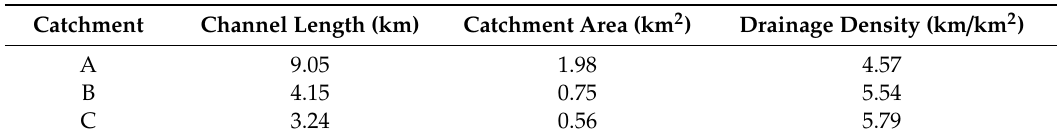
Table 1. Values of the total channel length, catchment area, and drainage density for catchments A, B, and